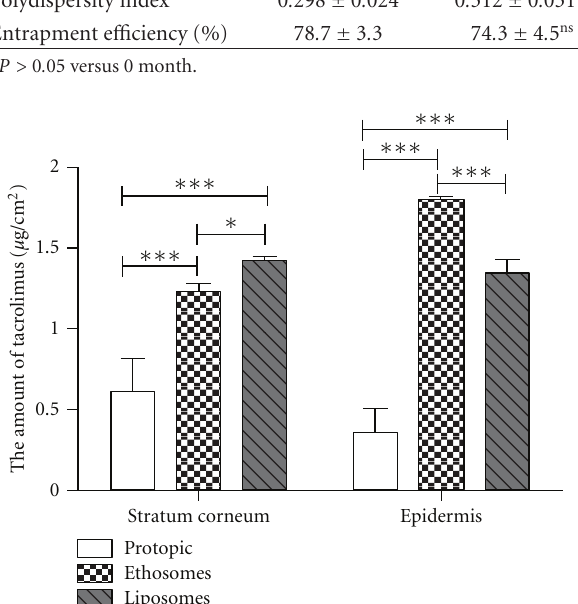
Figure 3: The amount of tacrolimus in stratum corneum and epidermis for tacrolimus